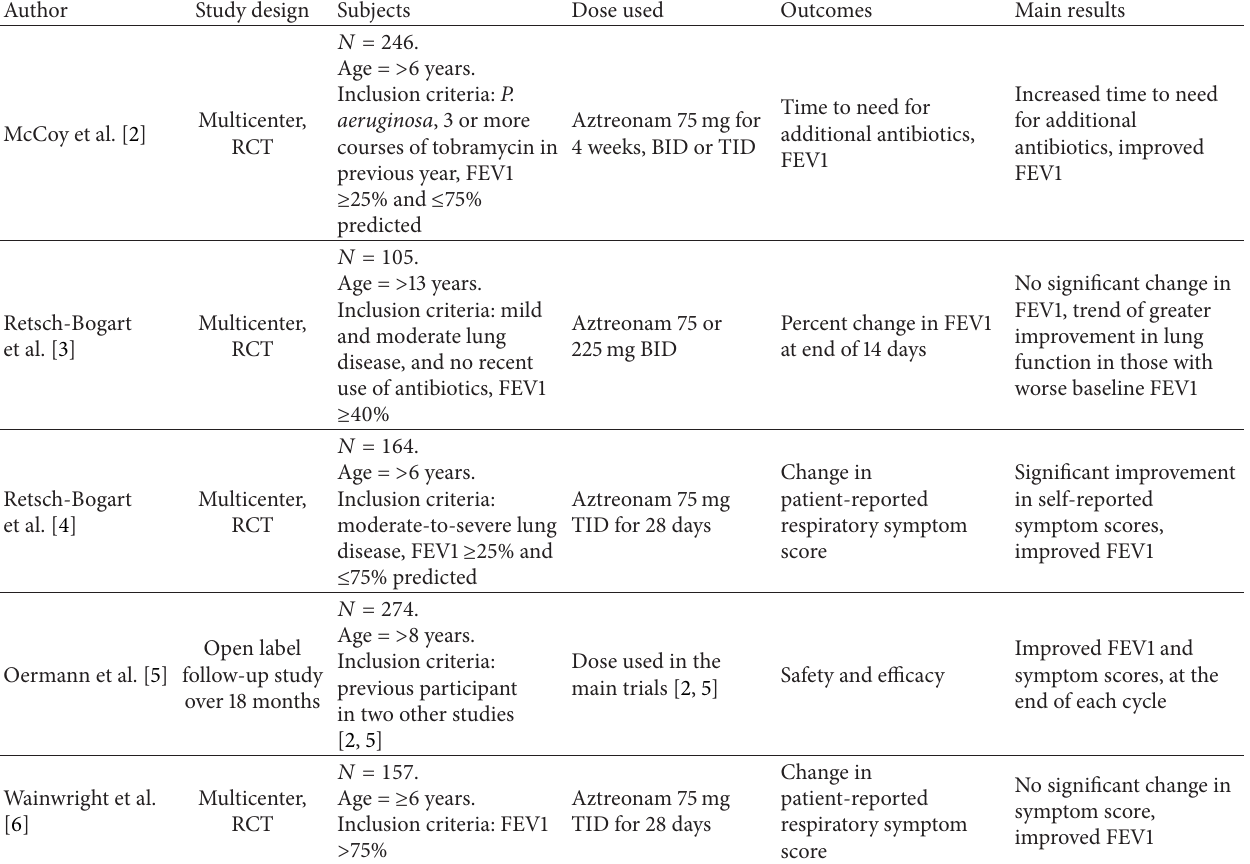
Table 1: Summary of AZLI